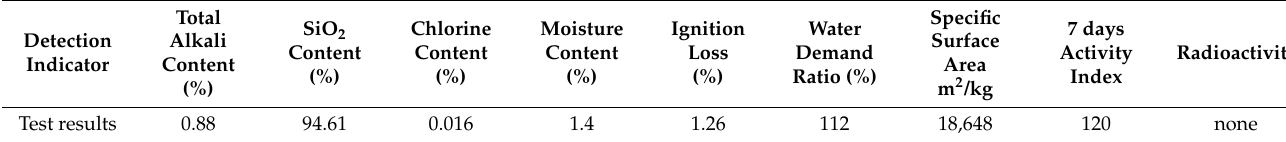
Table A3. Physical and chemical properties of silica fume.